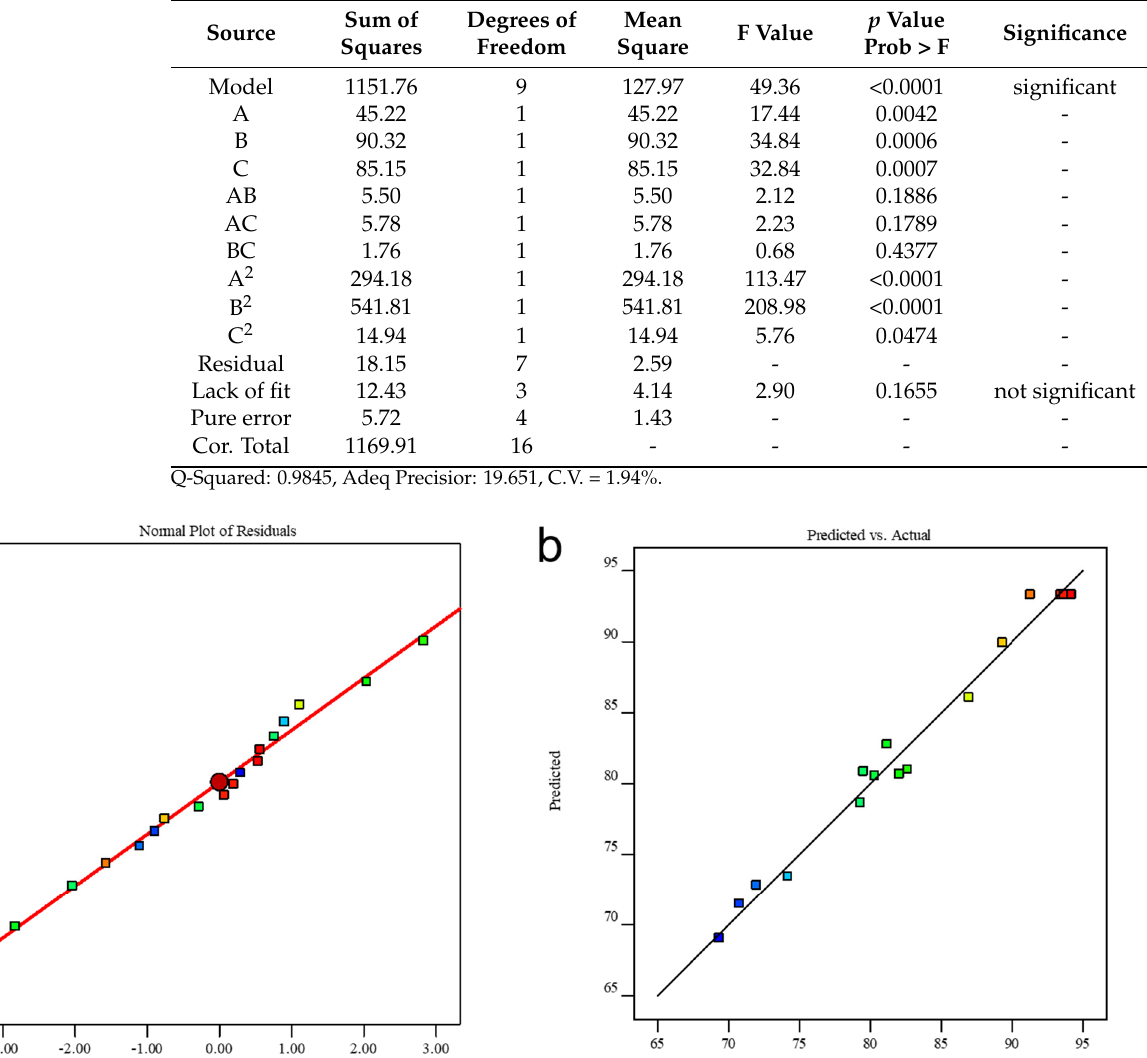
Table 3. Analysis of variance for the fitted quadratic model. Degrees Sum of of Mean Square F Value Source Squares Freedom Model